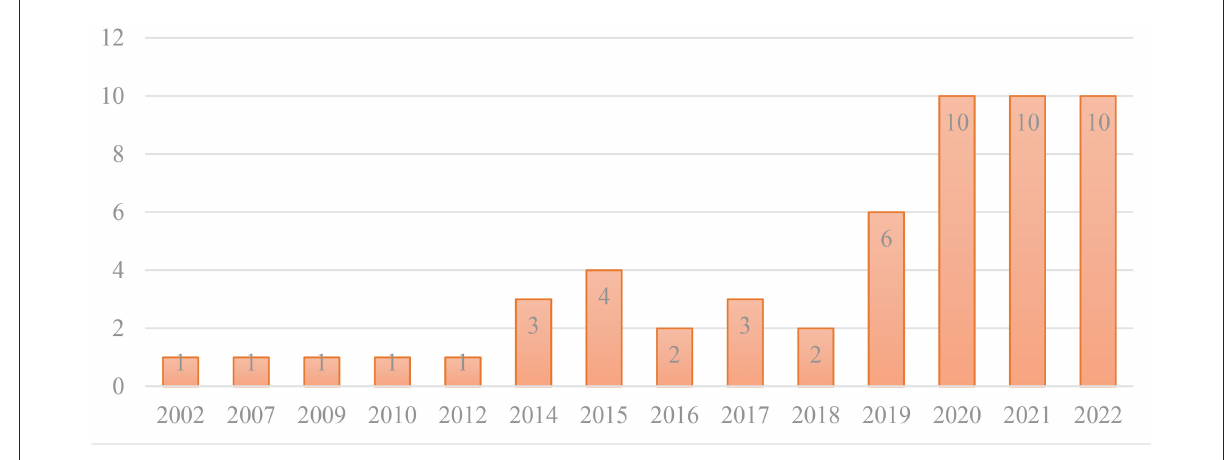
FIGURE3 Evolution of publication from 2007 to 2022. Source: our elaboration.